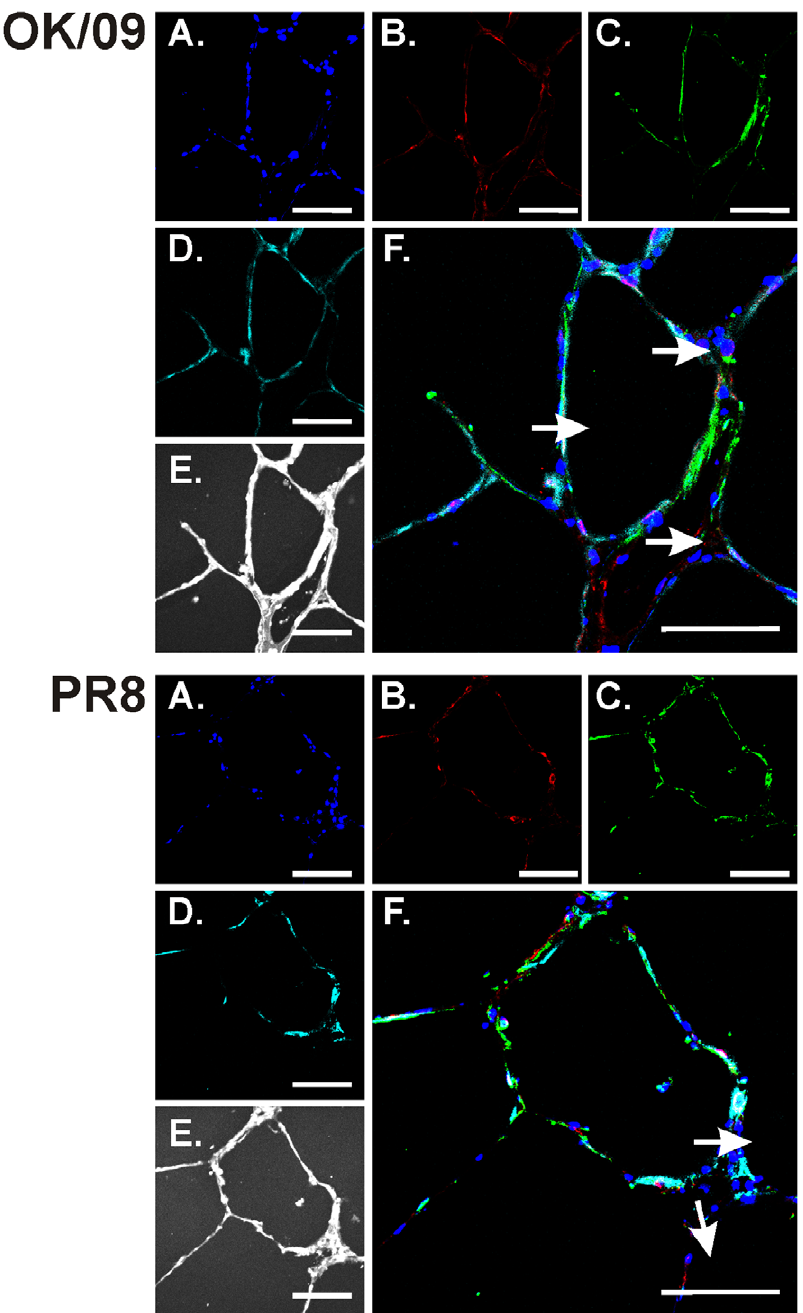
Figure 8. RIG-I and IP-10 induction in epithelial cells in the human lung. Lung slices were exposed to 6 6 10 6 PFU/ml of influenza virus PR8 or OK/09 or virus diluents for 24 h in the presence of BFA to enhance the detection of cytokines. Slices were then processed for immunohistochemistry for the detection of IP-10 using goat polyclonal antibodies, RIG-I using rabbit polyclonal antibody, and epithelial cells using anti-cytokeratin monoclonal antibody. Top : OK/09. Bottom : PR8. A–D : fluorescent images that demonstrate nuclei ( A ; blue), RIG-I ( B ; red), IP-10 ( C ; green), and epithelial cells ( D ; cyan). E : bright-field images. F : overlays of the fluorescent images that demonstrate that influenza induces RIG-I in epithelial cells (arrows). Bars=100 m m. 0.5 ml of LSM in a single well of a 24-well plate, and then incubated at 37 u C in 5% CO2. The LSM was replaced prior to subjecting the slices to the experimental treatments.